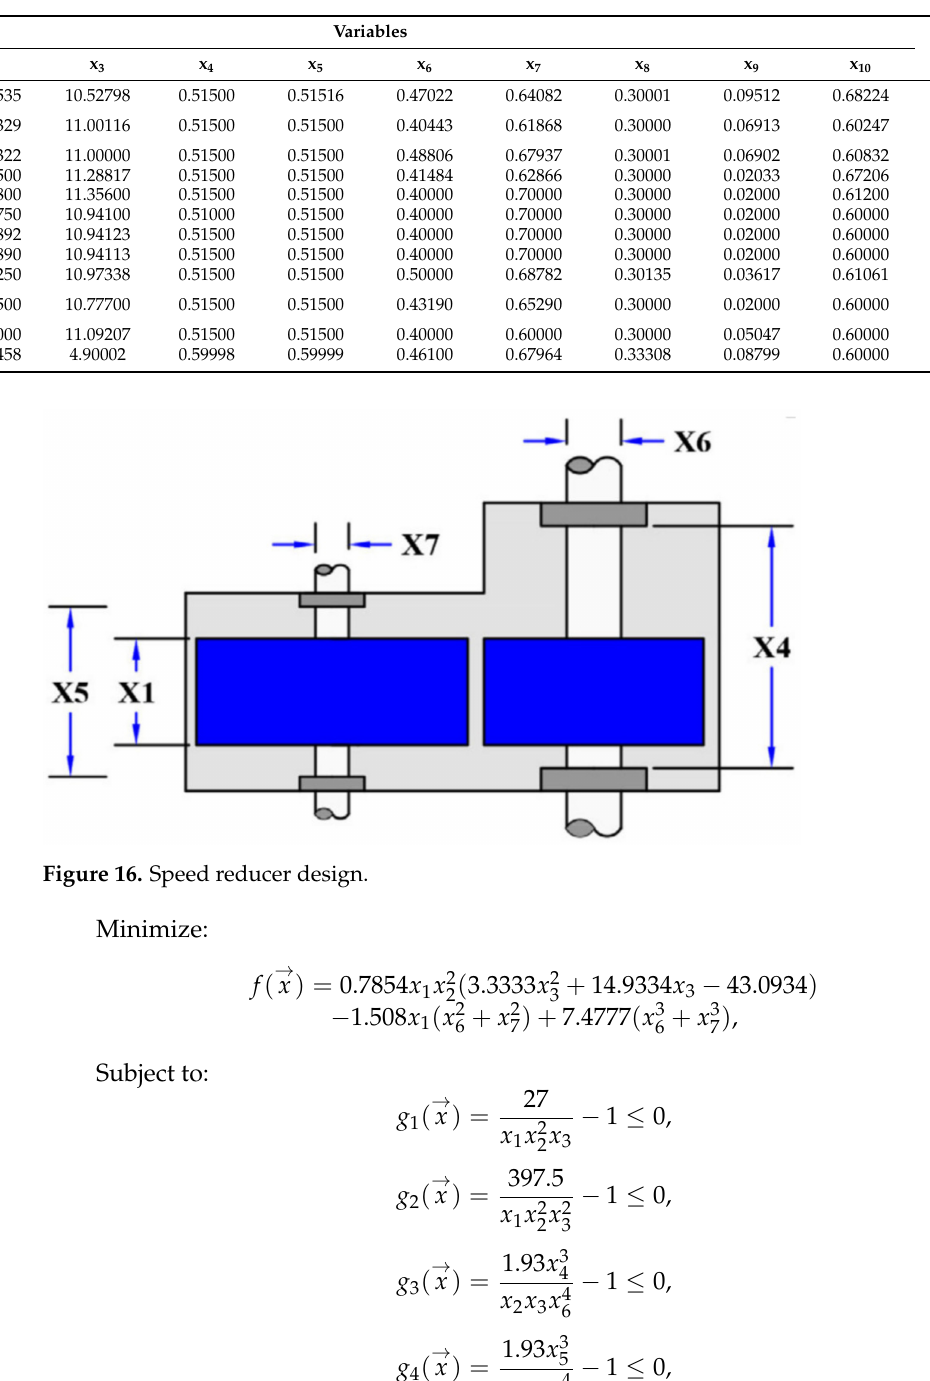
Table 18. Numerical comparison of the results obtained for the rolling element bearing in the literature.